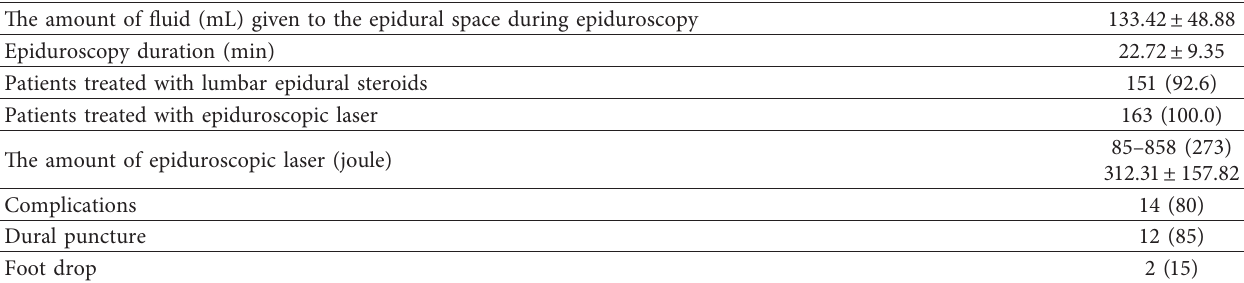
Table 2: Peroperative characteristics and complications of epiduroscopic discectomy procedures. The amount of fluid (mL) given to the epidural space during epiduroscopy